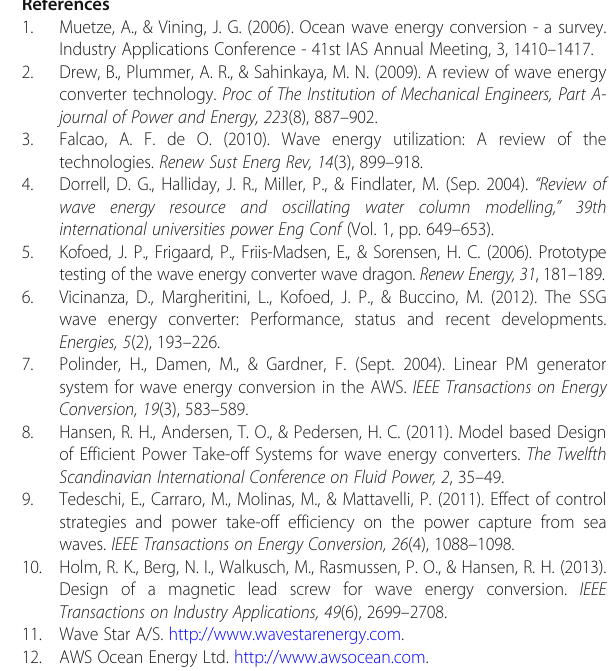
Fig. 7 Whole system energy efficiency at 42 MPa system pressure. a At sea state 3. b At sea state